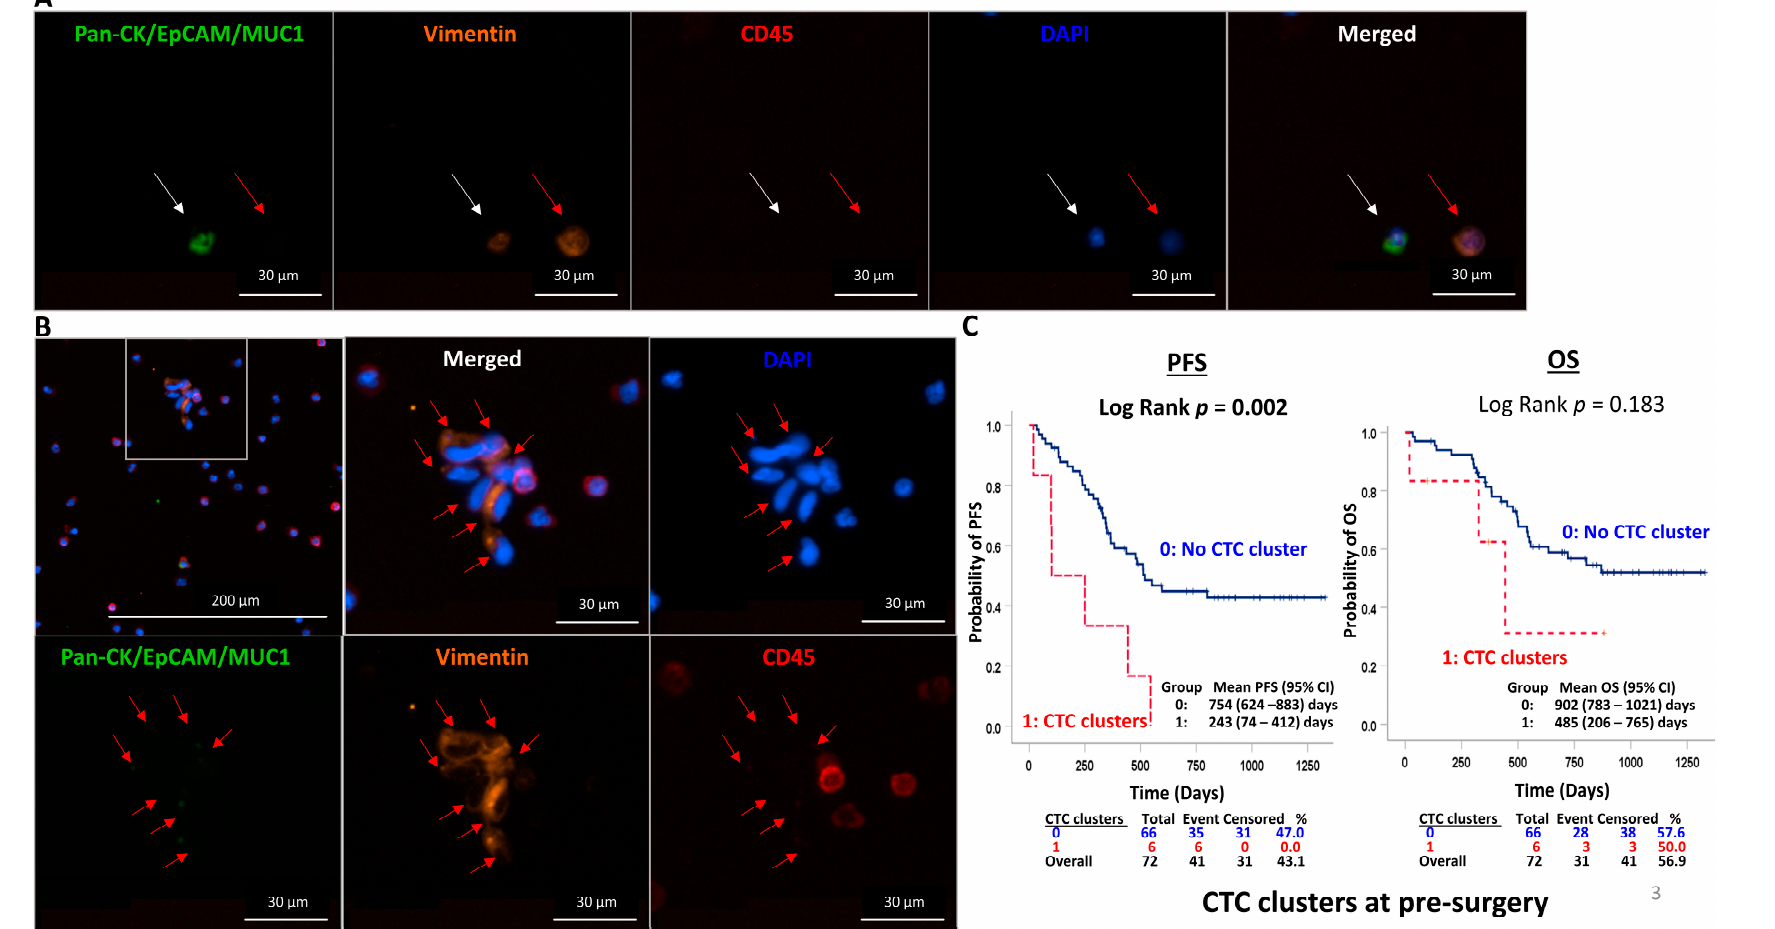
Figure 2. Double positive CTC, CTC M and CTC cluster. ( A ) Representative double-positive epithelial and mesenchymal CTCs (white arrow) and ( B ) mesenchymal CTCs (red arrows) in cluster enriched from the pre-surgery blood of ESCC patient T130. ( C ) Kaplan–Meier curve analysis indicated a shorter PFS and a trend of shorter OS between patients with versus without pre-surgery CTC clusters. PFS: progression-free survival, OS: overall